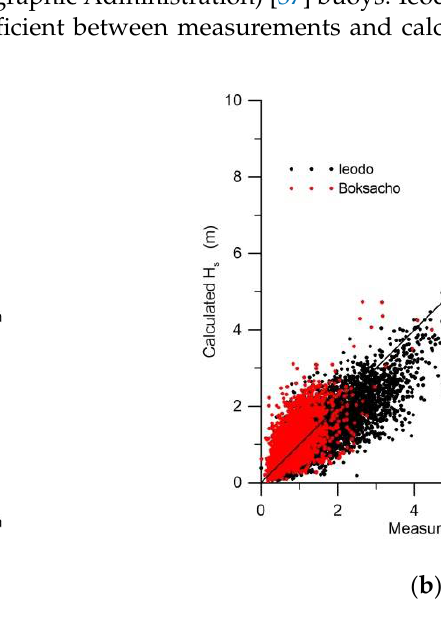
H in 2011 s H in 2011 s